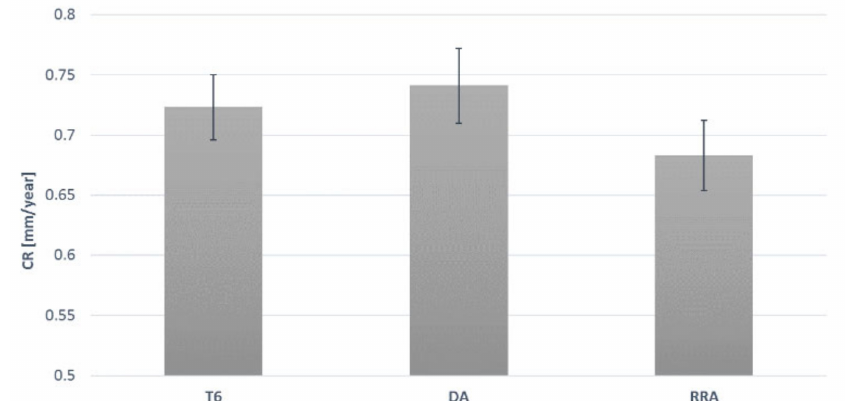
Figure 11. Corrosion rate CR obtained for particular states of heat